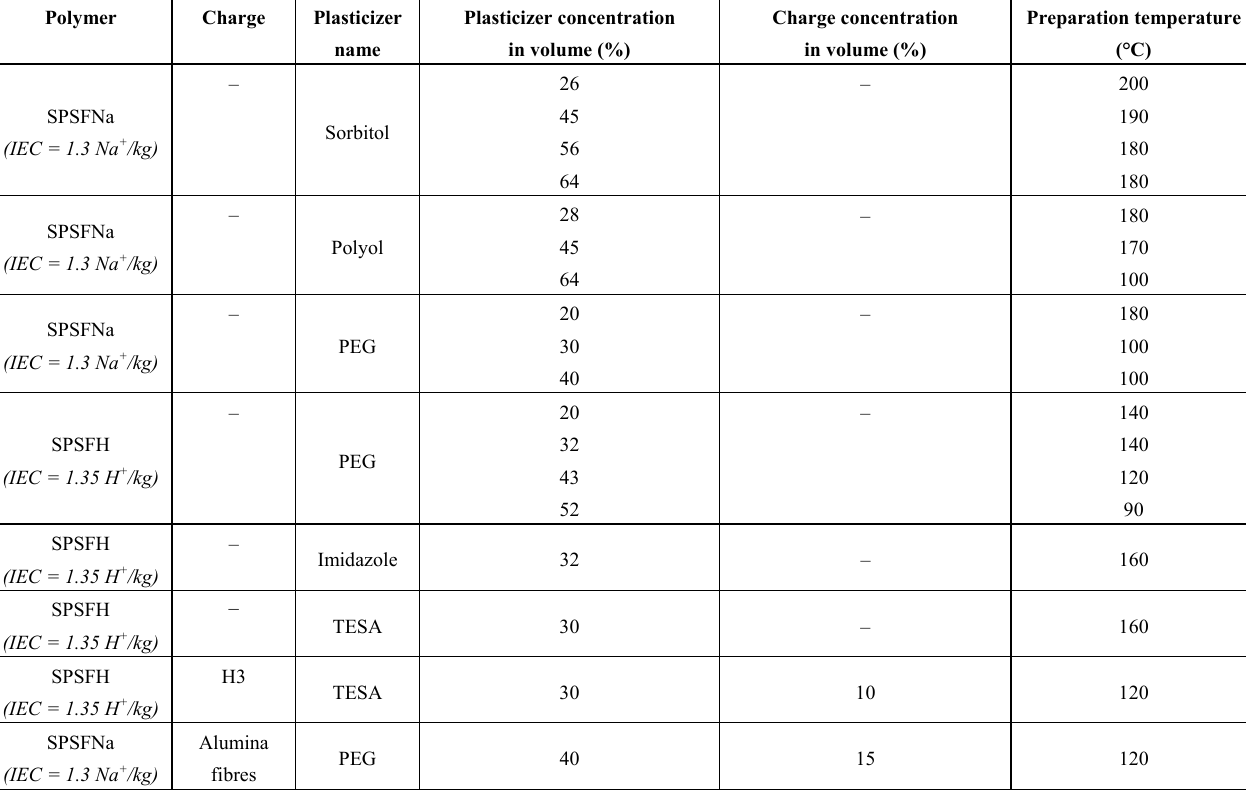
Table 4. Characteristics of the blends of plasticizers / sulfonated